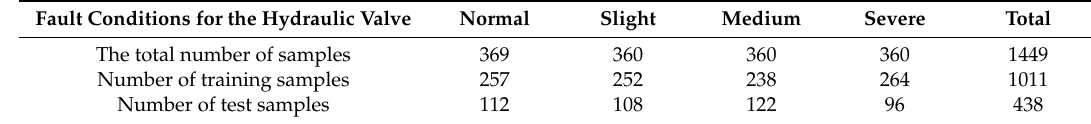
Table 4. The proportion sets of sample data for the hydraulic valve (V10).